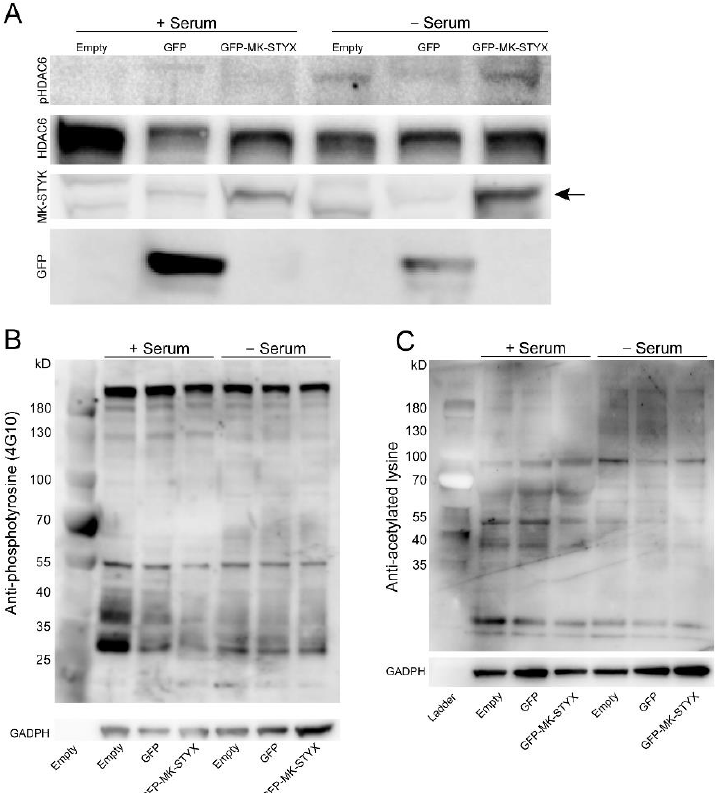
Figure 3. MK-STYX decreases the phosphorylation of HDAC6. ( A ) Twenty-four hours post-transfection cells were serum starved (− serum) or not (+ serum), lysed 24 h thereafter, and immunoblotted. Anti-phospho-HDAC6 antibody showed that MK-STYX decreased HDAC6 phosphorylation in non-serum starved cells relative to the cells overexpressing green fluorescence protein (GFP). However, MK-STYX increased HDAC6 phosphorylation in cells depleted of serum relative to GFP-expressing cells. These blots were stripped and probed for HDAC6 as a loading control. The blot was also stripped and probed with anti-GFP antibody to detect GFP (~27 kDa) or anti-STYXL1 (MK-STYX). Anti-STYXL1 antibody showed overexpressed GFP-MK-STYX (~67 kDa; indicated by the black arrow) relative to GFP (control vector) and non-transfected cells to confirm transfection. Three biologically independent replicate experiments were performed. ( B ) Samples were also used to detect effects of MK-STYX on tyrosine phosphorylation of proteins in the presence and absence of serum with the anti-phosphotyrosine antibody (clone 4G10). Cells expressing GFP-MK-STYX showed decreased phosphorylation relative to the controls in the presence of serum. The blot was stripped and probed with anti-GADPH (glyceraldehyde-3-diphosphatedehydrogenase; 37 kDa) antibody for a loading control. ( C ) Samples were also analyzed for acetylation with anti-lysine acetylation antibody to determine any effects of MK-STYX on acetylated proteins. In the presence or absence of serum, acetylation was decreased in cells expressing MK-STYX relative to control cells. The blot was stripped and probed with anti-GAPDH for a loading control. Three biologically independent replicates were performed.